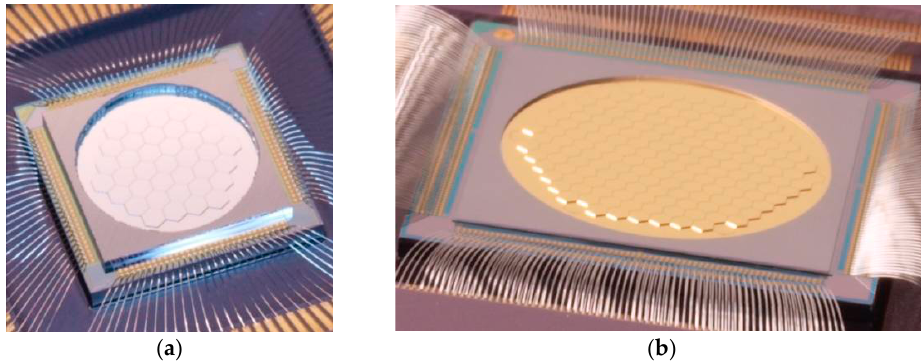
Figure 3. ( a ) Photograph of protected-silver coated PTT111 Deformable Mirror (DM) mounted in a ceramic package. The 111 actuator DM is comprised of 37 PTT segments tiled in a hex-packed array with an inscribed aperture of 3.5 mm; ( b ) Photograph of gold-coated PTT489 DM. The 489 actuator DM is comprised of 163 PTT segments with an inscribed aperture of 7.7 mm. The 700 µm